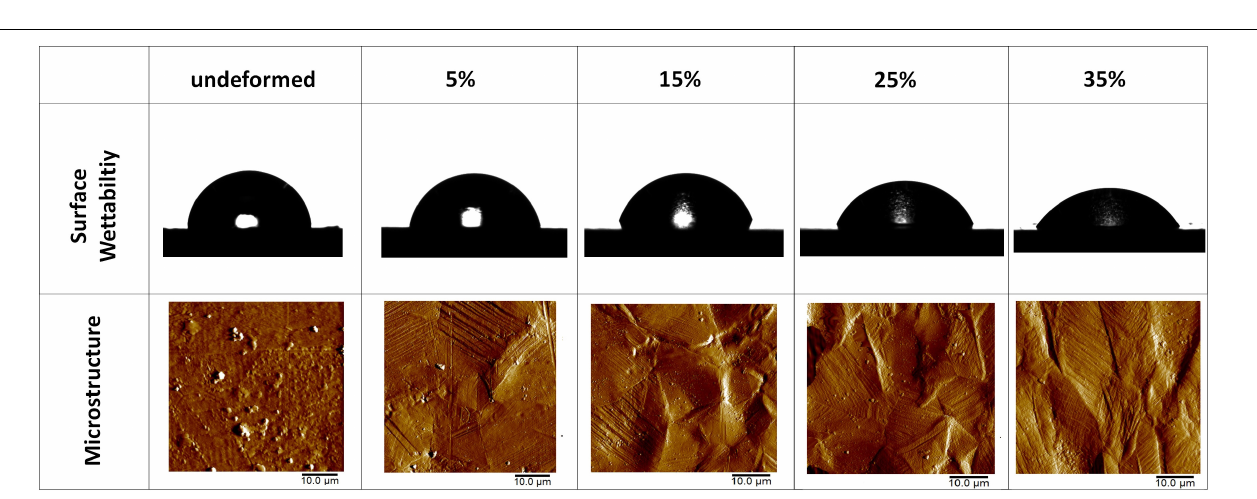
FIGURE 3 | Topographical images of the undeformed and deformed samples obtained via AFM. (Figure is more readable and visible on the screen rather than in print).